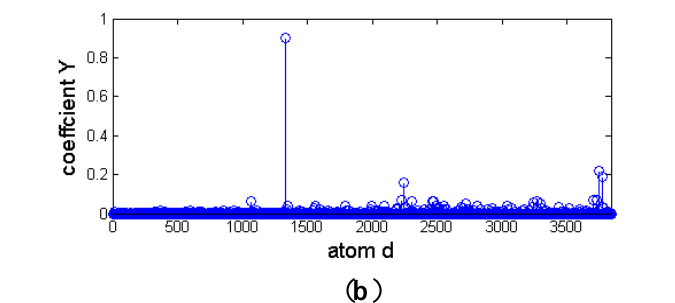
Figure 3. Representation coefficient of a deep space image decomposed based on a Gaussian over-complete dictionary. ( a ) and ( b ) are target signal and its sparse coefficient, respectively; ( c ) and ( d ) are background noise and its sparse coefficient,